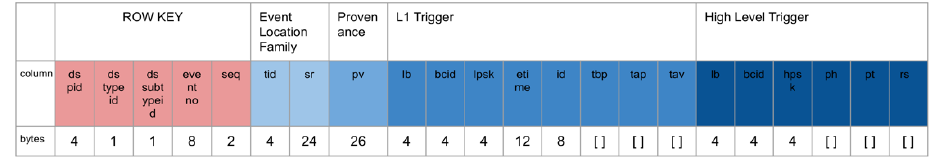
Fig. 2 : RowKey schema for the HBase”Phoenix version of the EventIndex data store.